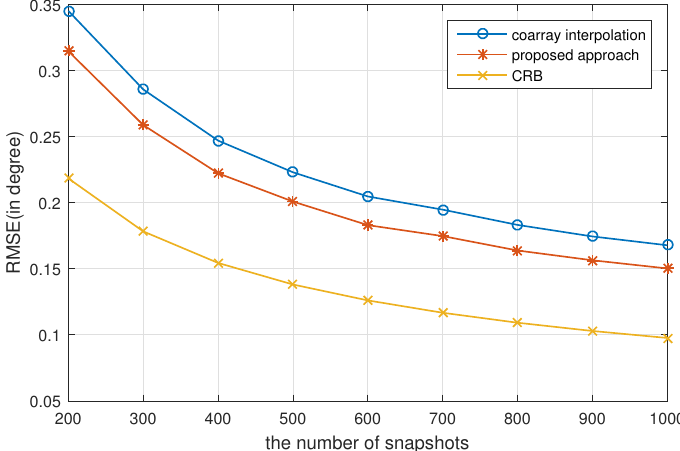
Figure 4. RMSE vs. the number of snapshots for 500 Monte Carlo experiments with Q = 16 sources uniformly distributed in [ − 50 ◦ ,50 ◦ ] . The SNR is 0